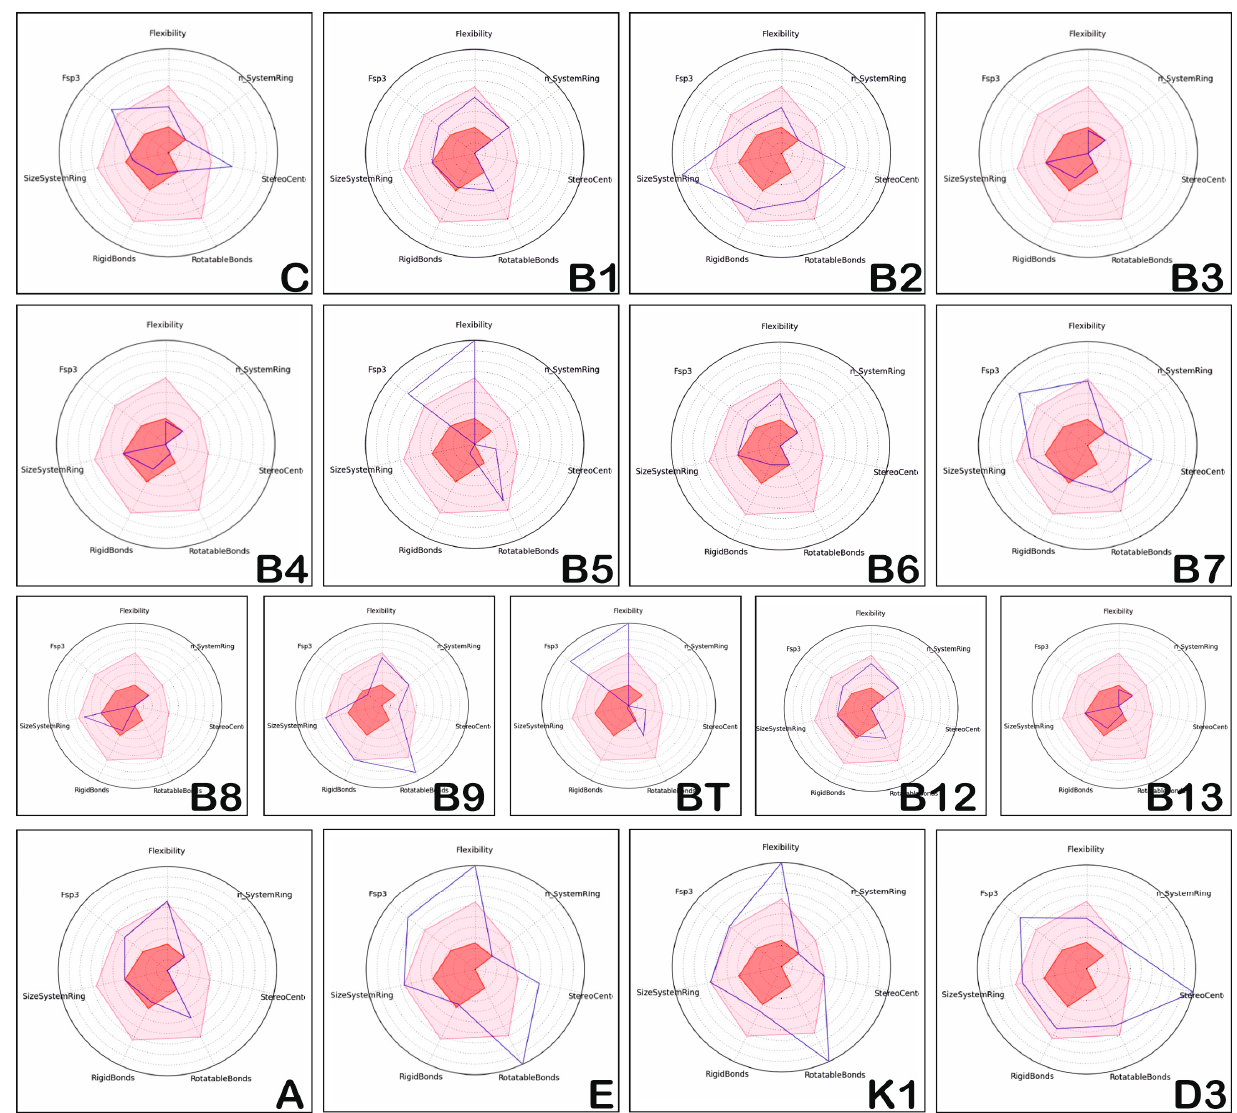
Figure 2. Position of complexity of hydro-soluble vitamins and liposoluble vitamins. The positioning of the physico-chemical properties of hydro and liposoluble vitamins (the dark line in Figure 2) corresponds to the properties of most compounds with proven therapeutic potential (the light red area corresponds to the area of chemical compounds with biological activity and oral bioavailability). Studying Figure 2, we can state that the physico-chemical properties reflecting the structural complexity of vitamins (blue lines) do not correspond to those observed for drug-like compounds (light red areas). Vitamins C, B1, B9, B12 and A have physico-chemical properties that usually fit in the light red area, vitamins B3, B4, B6, B8 and B13 show a reduced structural complexity, and vitamins B2, B5, B7, BT, E, K1 and D3 illustrate increased structural flexibility. The same is true of the hydro-soluble vitamins, C, B2, B5, B7, B9 and BT. Moreover, vitamins C, B3, B4, B6, and B13 have properties in the forbidden area (dark red area).